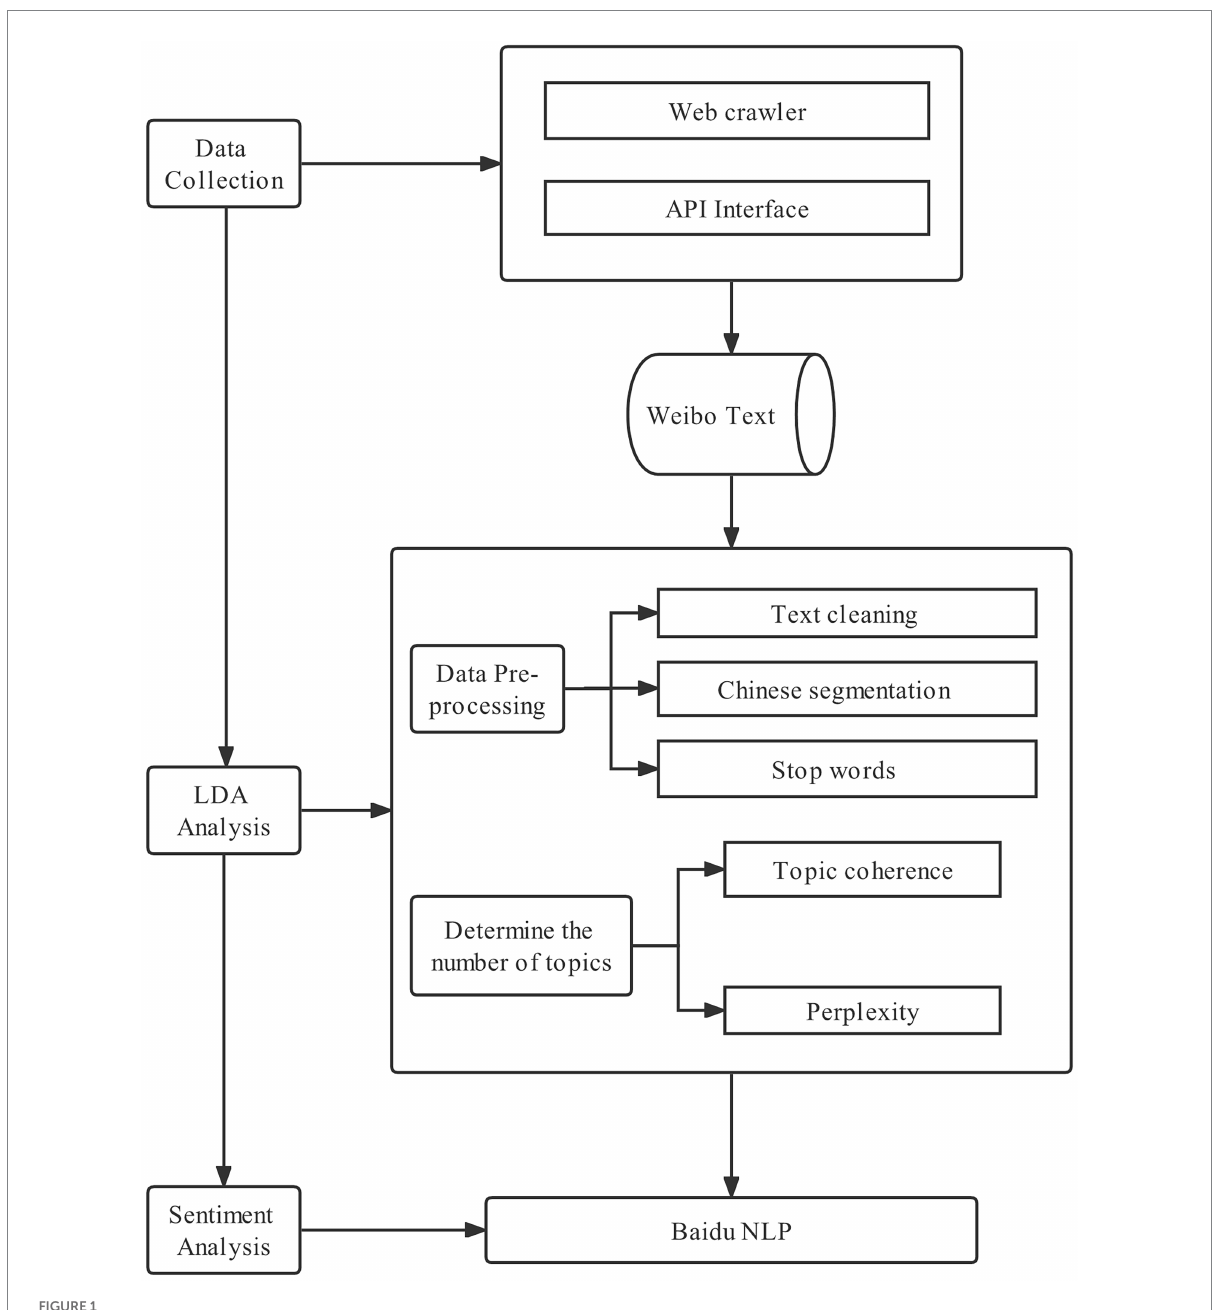
FIGURE 1 Framework of the data analysis